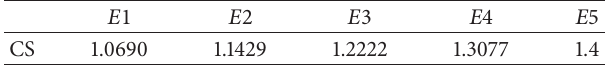
Table 3: CS for different enhanced versions.